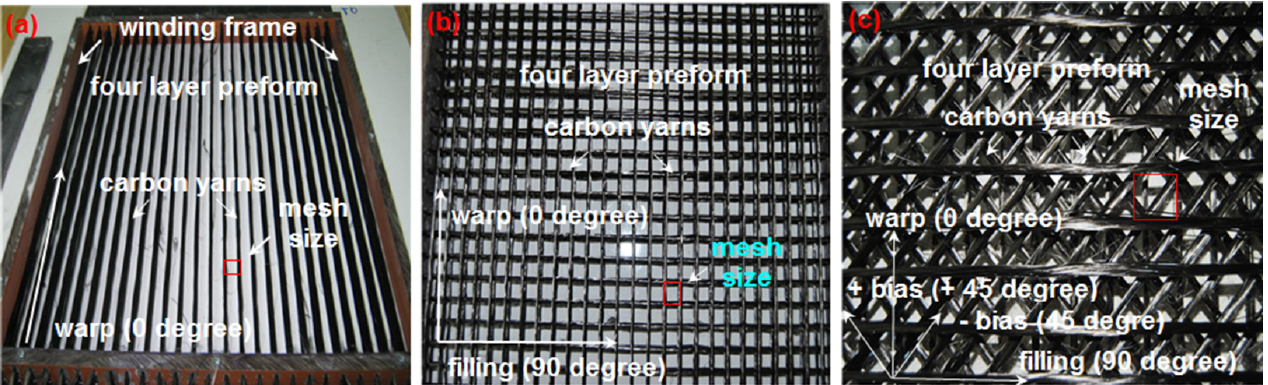
Figure 1. Various multiaxis 3D carbon preforms for concrete structures produced by “winding and molding” method. ( a ) Unidirectional preform (C-1D); ( b ) biaxial preform (C-2D); ( c ) multiaxis preform (C-4D) (digital image).